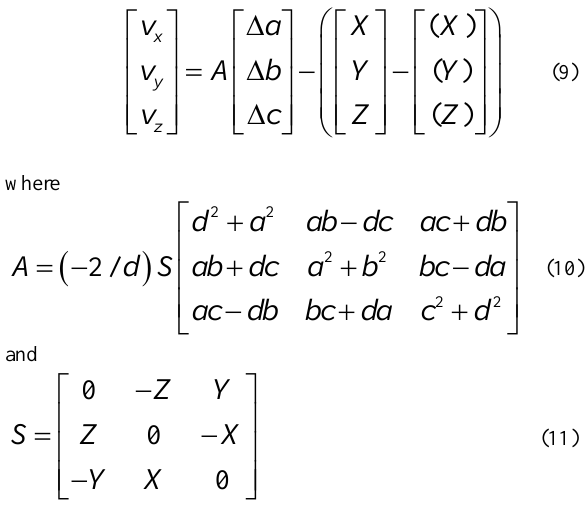
From the 25 corresponding pairs, 15 pairs of the normal vectors of planes were randomly chosen as the input to the 3D conformal transformation. The other 10 pairs were used as “check normal vectors” for evaluation purpose. The differences at these check planes are given in Tables 1 and 2.